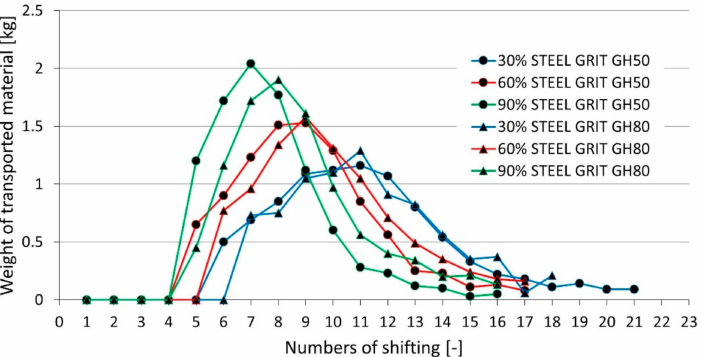
Figure 12. Dependence of weight of the transported steel abrasive materials, STEEL GRIT GH50 and GH80, in the case of one stroke on sequence of the stroke during gradual feeding of the conveyor with 10 kg of this material at the 30%, 60% and 90% levels of shifting speed.